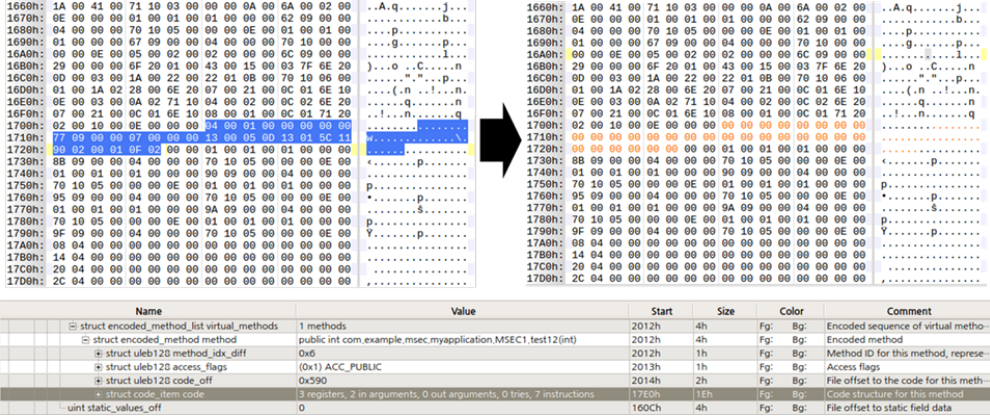
Figure 27. Delete the Dalvik